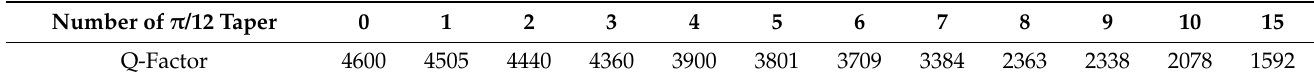
Figure 5. Transmittance curve for ring designed with zero tapered parts to 15 * ( π /12); (* is cross). Table 1. Quality factor versus number of π /12 tapered parts in the ring.